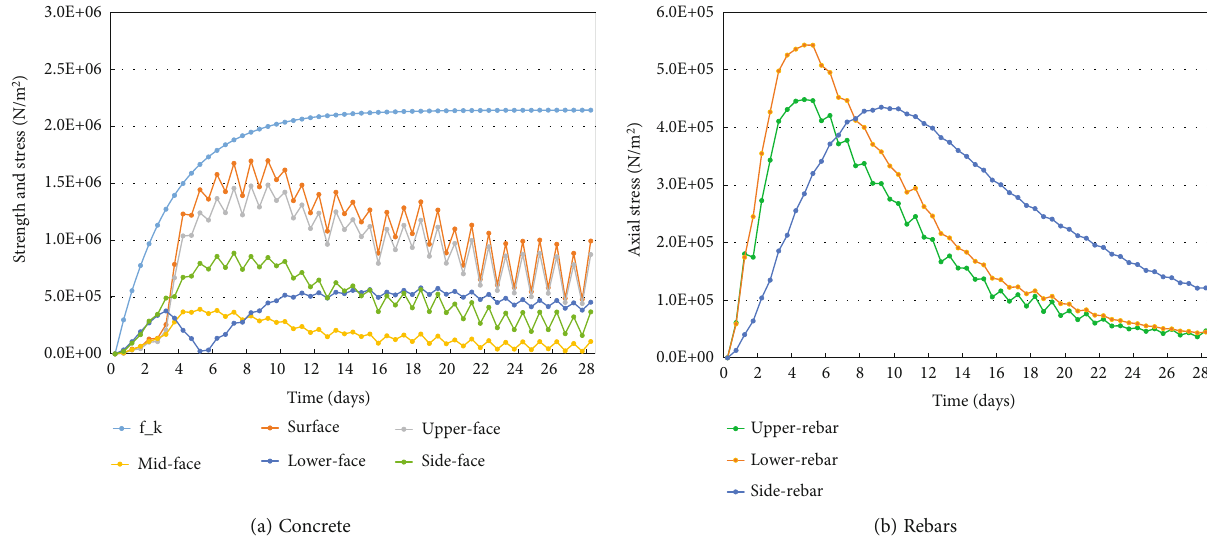
Figure 6: Temperature stress and axial stress of